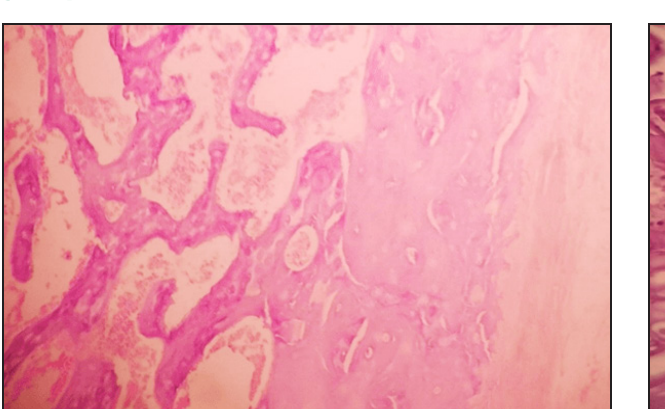
Figure-II: Gait pattern of rat of triamcinolone group